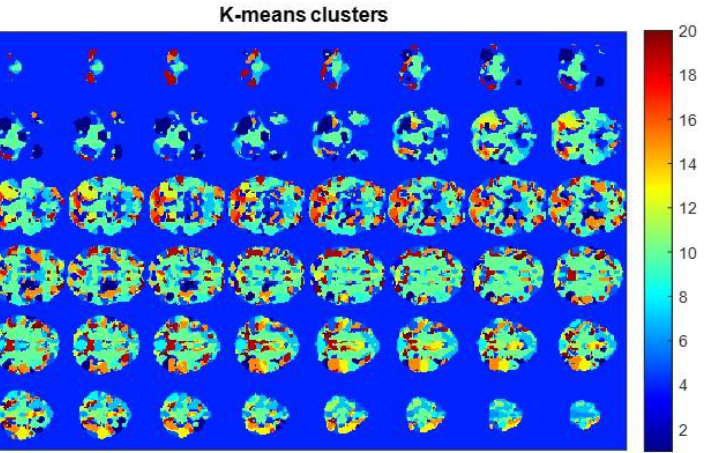
Figure A4. Spatial clusters obtained after k-means clustering. The clusters are color coded, and the color bar represents the color corresponding to cluster numbers.